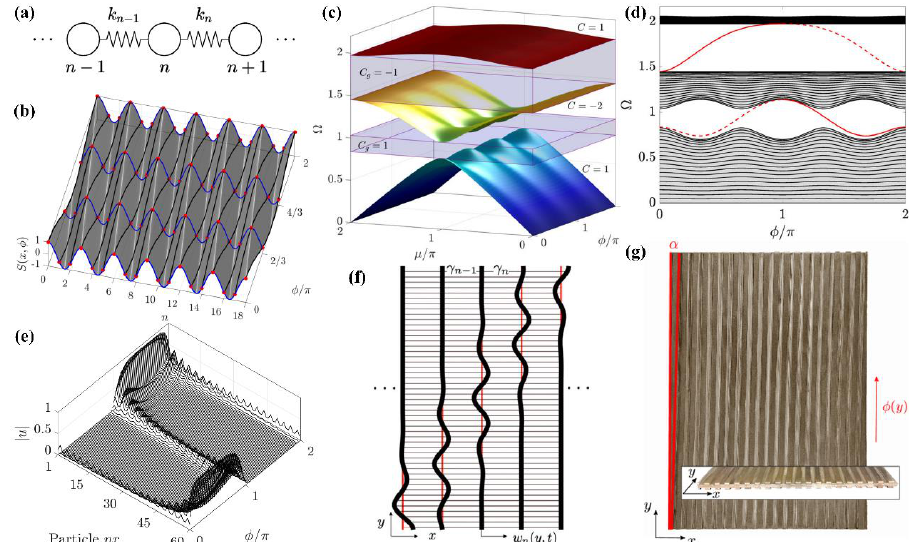
Figure 7. Spatially modulated elastic lattices. ( a ) 1D lattices model with modulated spring stiffness k n = k 0 [ 1 + α cos ( 2 π np / q + φ )] [128]. ( b ) 2D surface S ( x , φ ) = cos ( 2 πτ x + φ ) . The black lines denote stiffness variation with φ at a lattice node, and the blue lines denote cross-sections at φ r = ( 2 π r /3 )( r ∈ [ 0,3 ]) [128]. ( c ) The dispersion surfaces with Chern numbers labeled on the gaps [128]. ( d ) The energy spectrum as a function of φ . The red lines signals the edge modes [128]. ( e ) The transition of the edge wave across the system from left to right as the variation of φ in he second gap. [128]. ( f ) The array of continuous beams: the thick black lines signal the notional deformed beams, the thick red lines signal the undeformed beams, and the thin black horizontal lines correspond to the distributed springs with coupling constant γ n [128]. ( g ) The square wave modulated continuous elastic plate employed in experiments [130]. ( , ) u 2 ( , ) [0,2 ] = T 2 = D T , ( / ) ( / ) e + denotes an opposite transition in the sec-